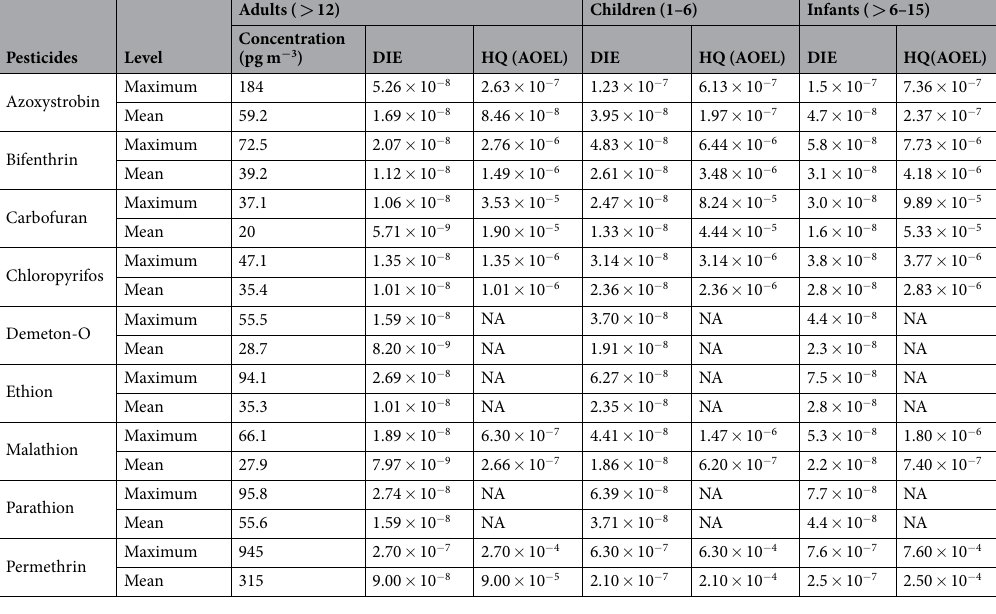
Table 6. Maximum and average concentration (pg m − 3 ) of pesticides in PM2.5 samples and values of Daily Inhalation Exposure (DIE) (mg kg − 1 day − 1 ) and Hazard Quotient (HQAOEL). NA: AOEL values no available for theses